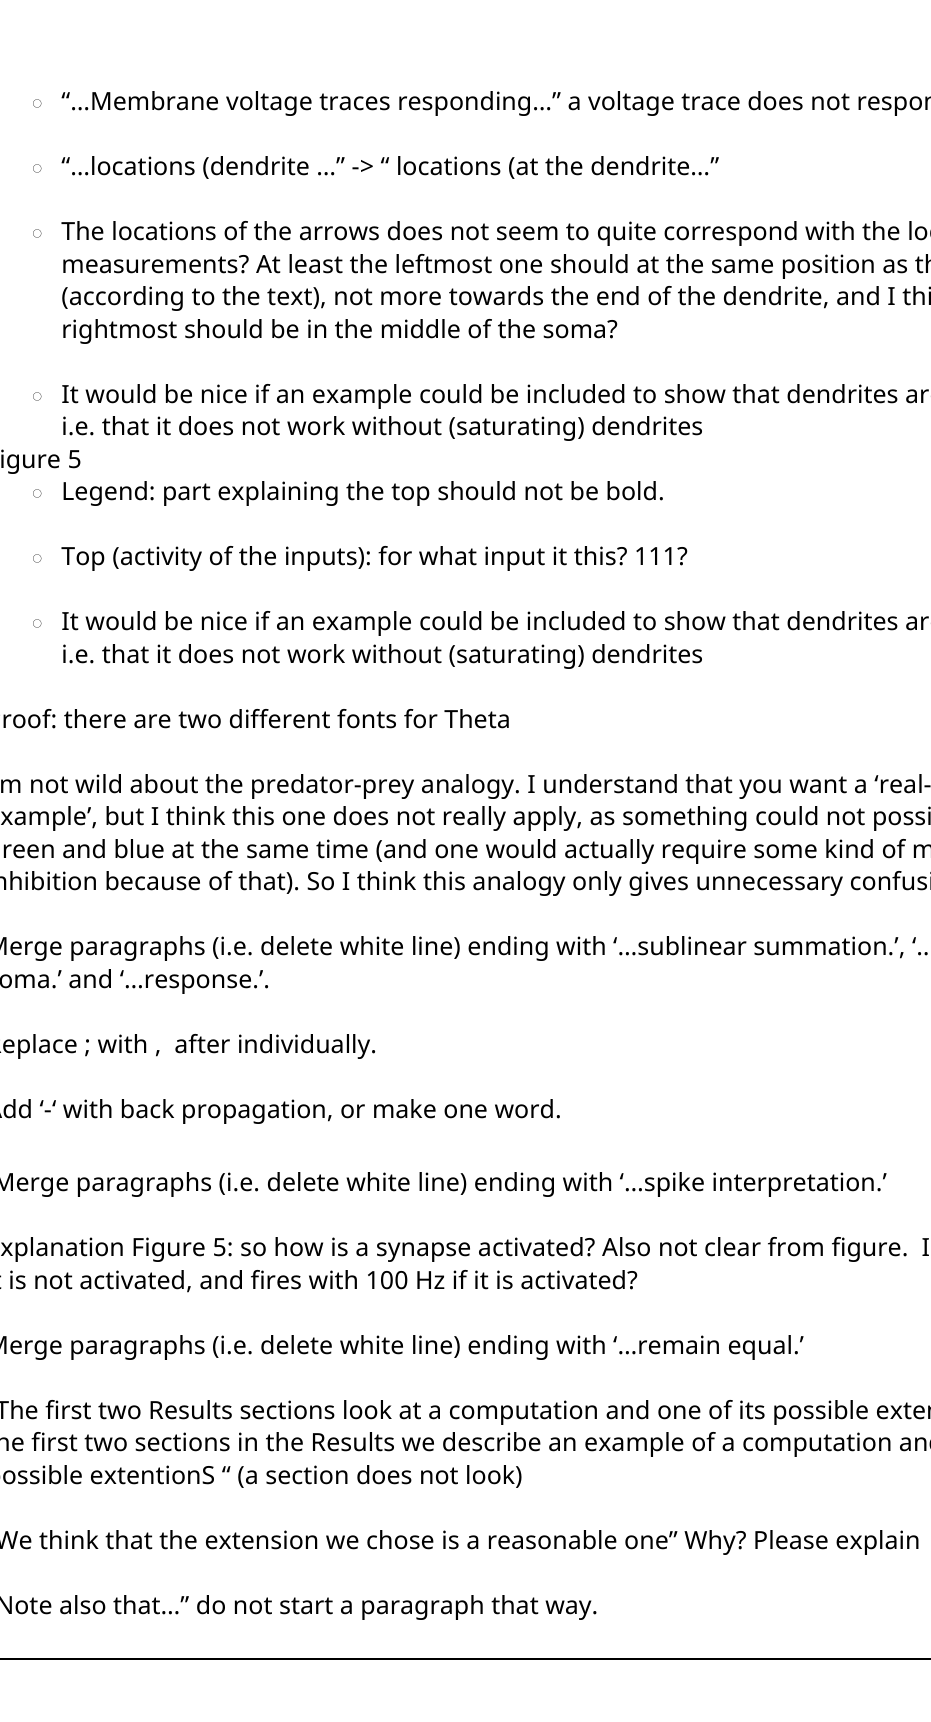
Legend: part explaining the top should not be bold.